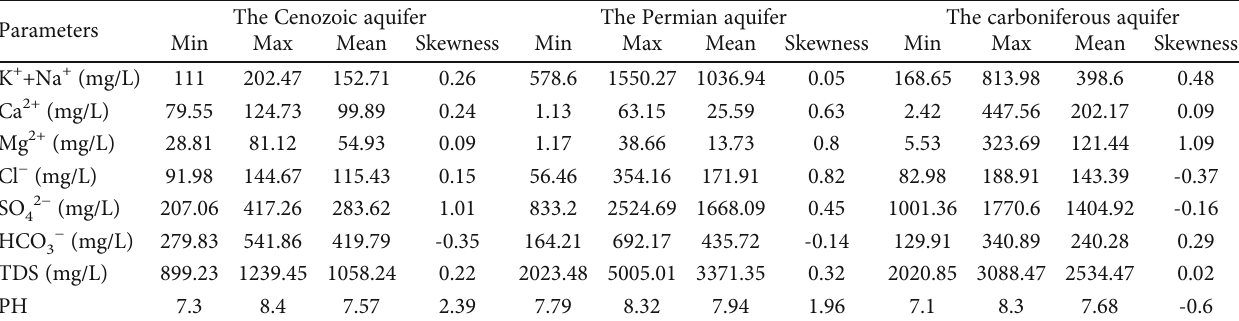
Table 1: Sample indexes-descriptive